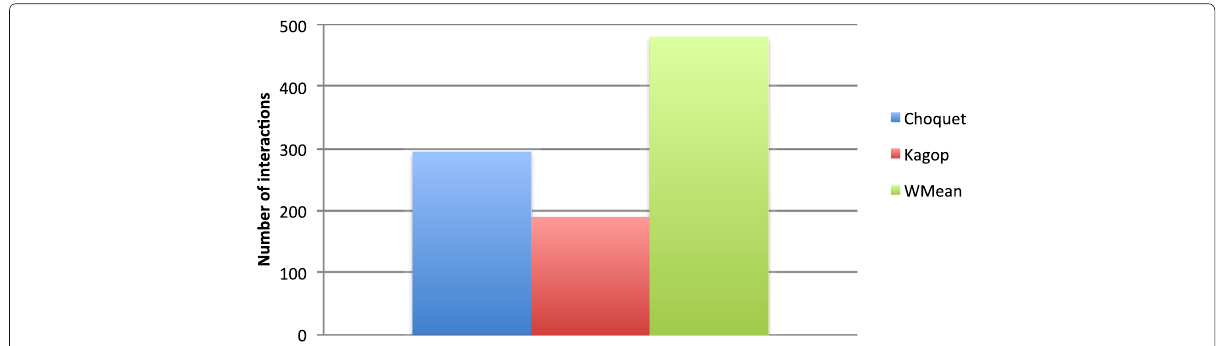
Fig. 13 Average number of